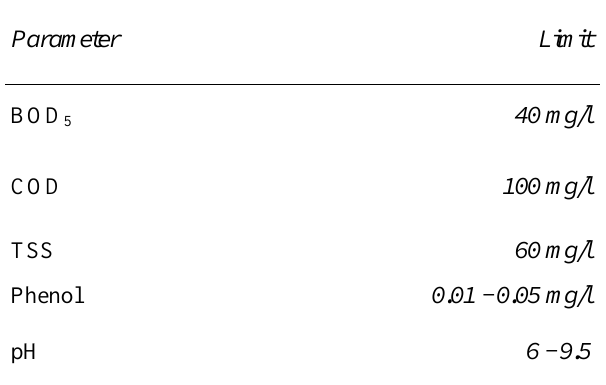
Figure 4: pH values of irradiated sample of wastewater for BOD 5 Table 2: Iraqi allowable values of conventional concentrations that can be disposed to the surface water [19].